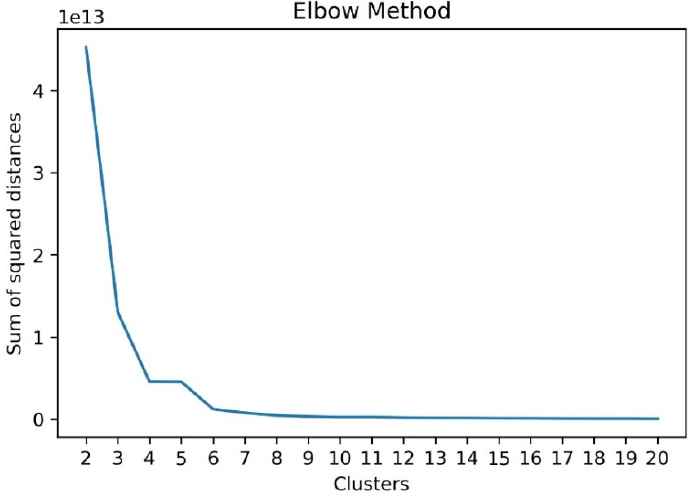
Figure 14. Inertia-based elbow method for clusters ranging from 2 to 20 using K-means clustering of client load profiles based on dynamic time warping.